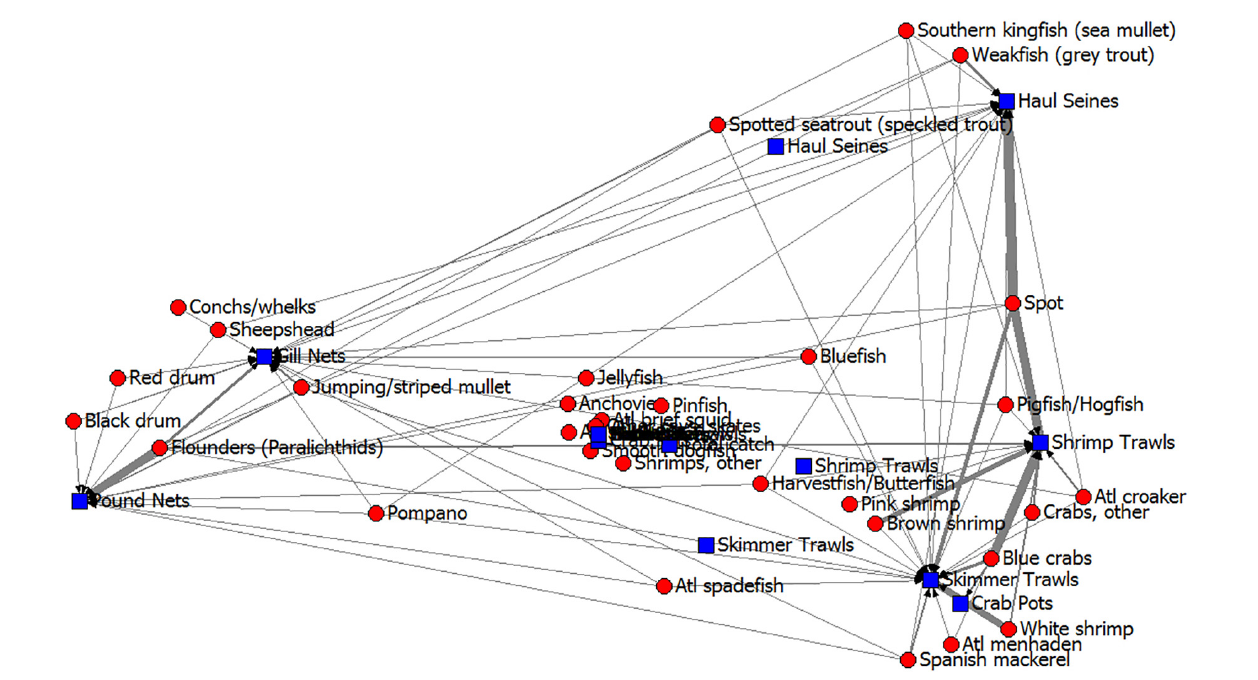
FIGURE 6 | Core Sound, NC commercial fisheries harvests from the annualized ECOPATH model in open-trawling areas shown as a correspondence analysis of gear type (blue squares) and their commercial catches (red circles). Arrows point from species harvested to fishery gear, with line thickness showing the amount of carbon from the Ecopath model flowing along that path. Gear types that plot together have similar selectivity, and species that plot together are harvested using similar fishery gear types.